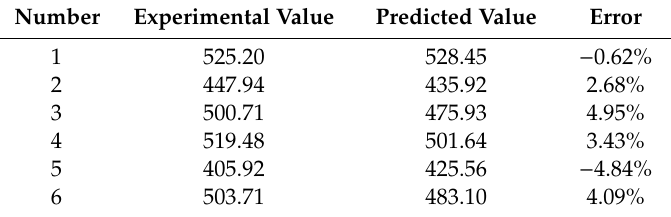
Table 14. Comparison of experimental values with predicted ones of diesel engine power (kW).